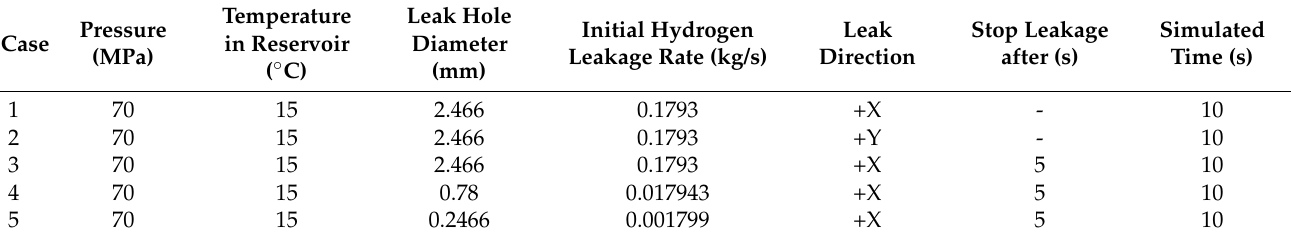
Table 1. Leakage cases of the